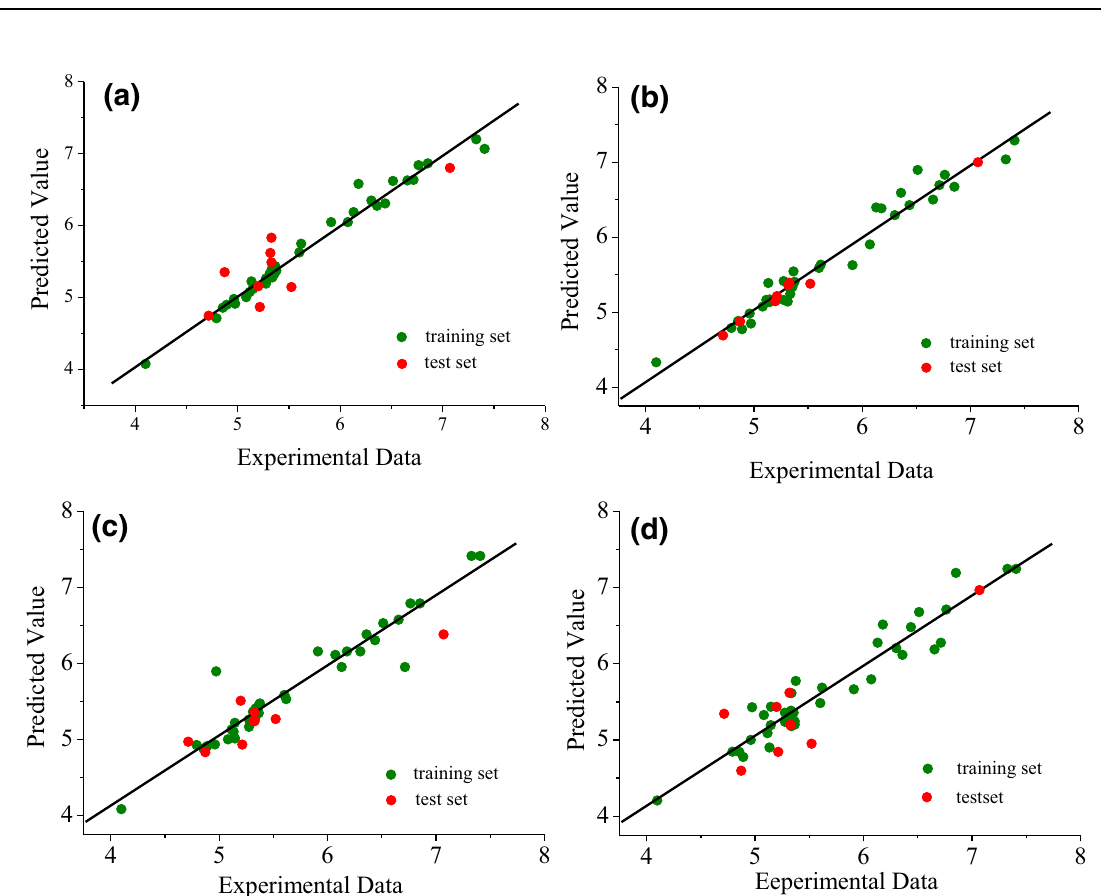
Fig. 3 Scatter diagram analysis using experimental and predicted data of QSAR models. a CoMFA; b CoMSIA; c topomerCoMFA; d